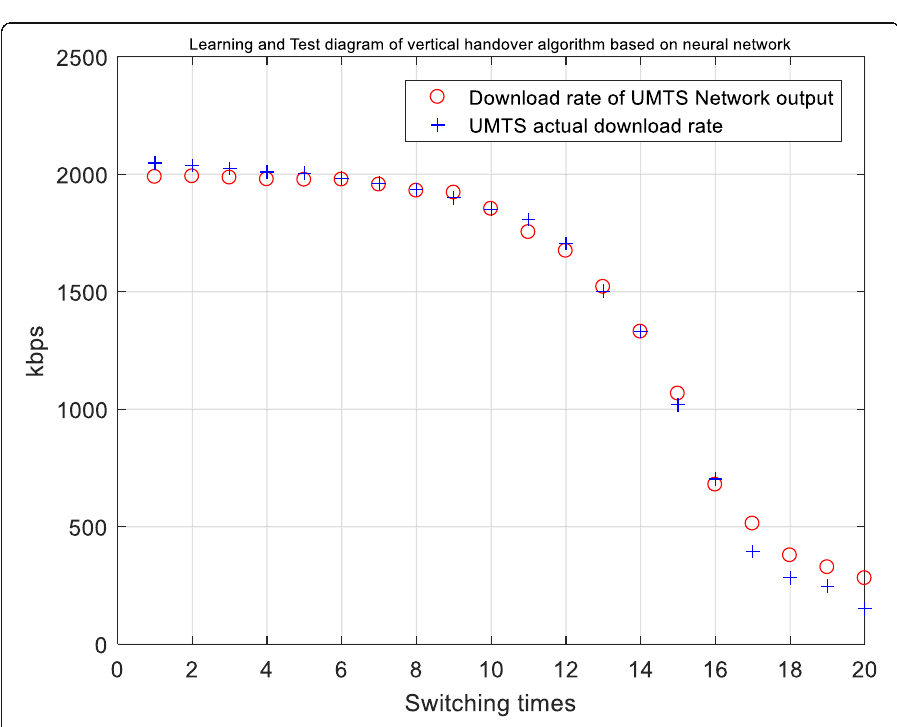
Fig. 7 Contrast curve of data learning and testing in UMTS